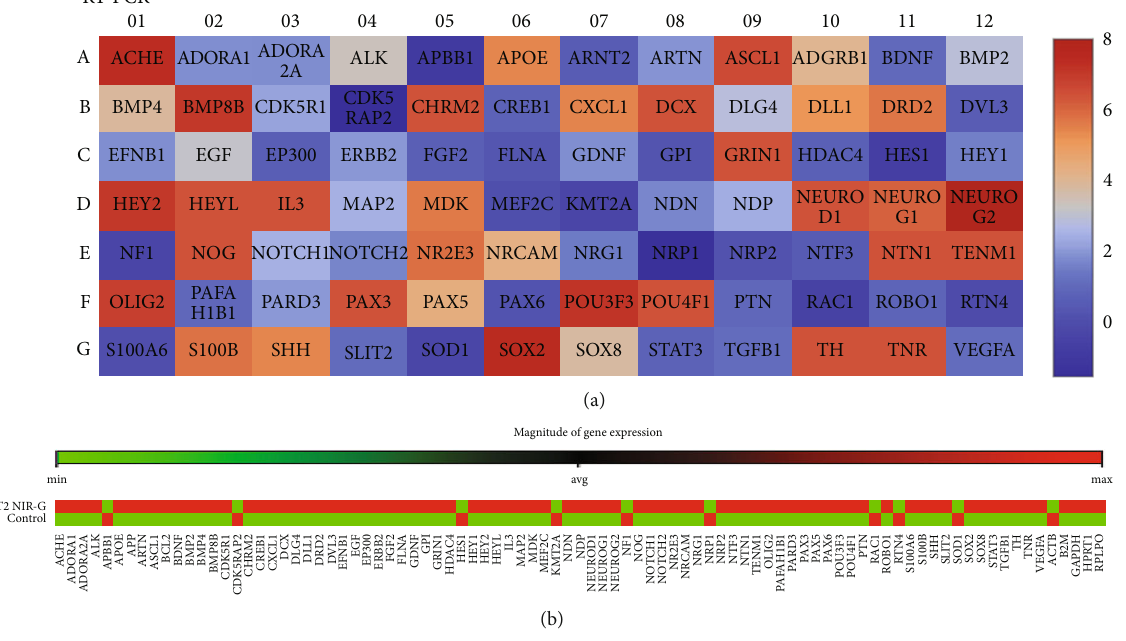
Figure 11: Real-time PCR of NIR-G transdi ff erentiated iADSCs. (a) Illustrative heat map indicated the fl uorescent intensity detection of each gene generated with GeneGlobe software, where red corresponds to high detection levels in the experimental group. (b) Clustergram compared the IT2 NIR-G treated group averages to the control averages, where red indicates high expression levels and green indicates low levels of